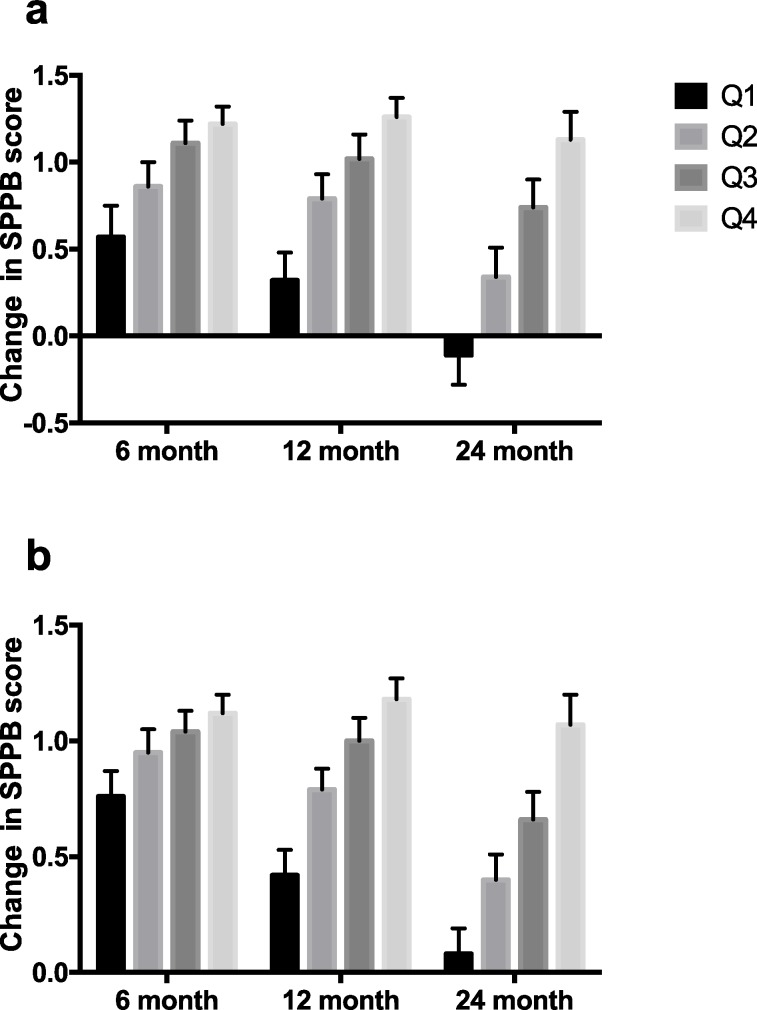
Change in SPPB score compared to baseline SPPB score at 6, 12, and 24 months according to quartiles of change in physical activity by accelerometry from baseline to 24 months, (a.) physical activity arm alone and (b.) entire group combined (least square means ± SE). Overall effect P < 0.0001. Effects within each time point all P < 0.01(physical activity arm); Effects within each time point all P < 0.06 (month 6, P = 0.06, months 12 and 24, P < 0.0001) (entire group).